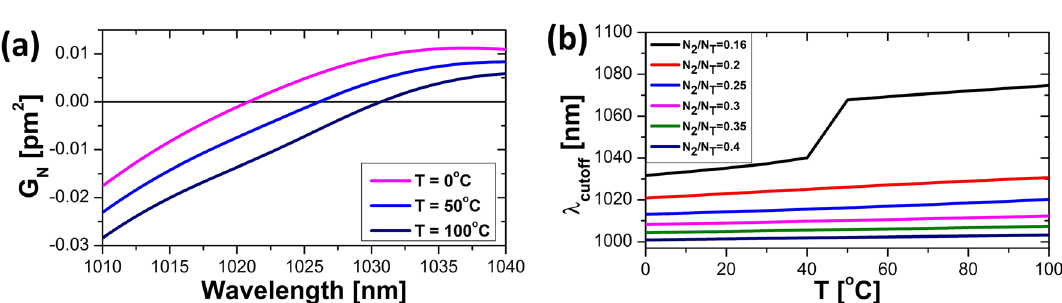
Figure 7. The normalized gain for an inversion level, N 2 /N T , of 0.2 at the indicated temperatures ( a ). The shift of the lower wavelength edge of the normalized gain for different inversion levels at various temperatures ( b